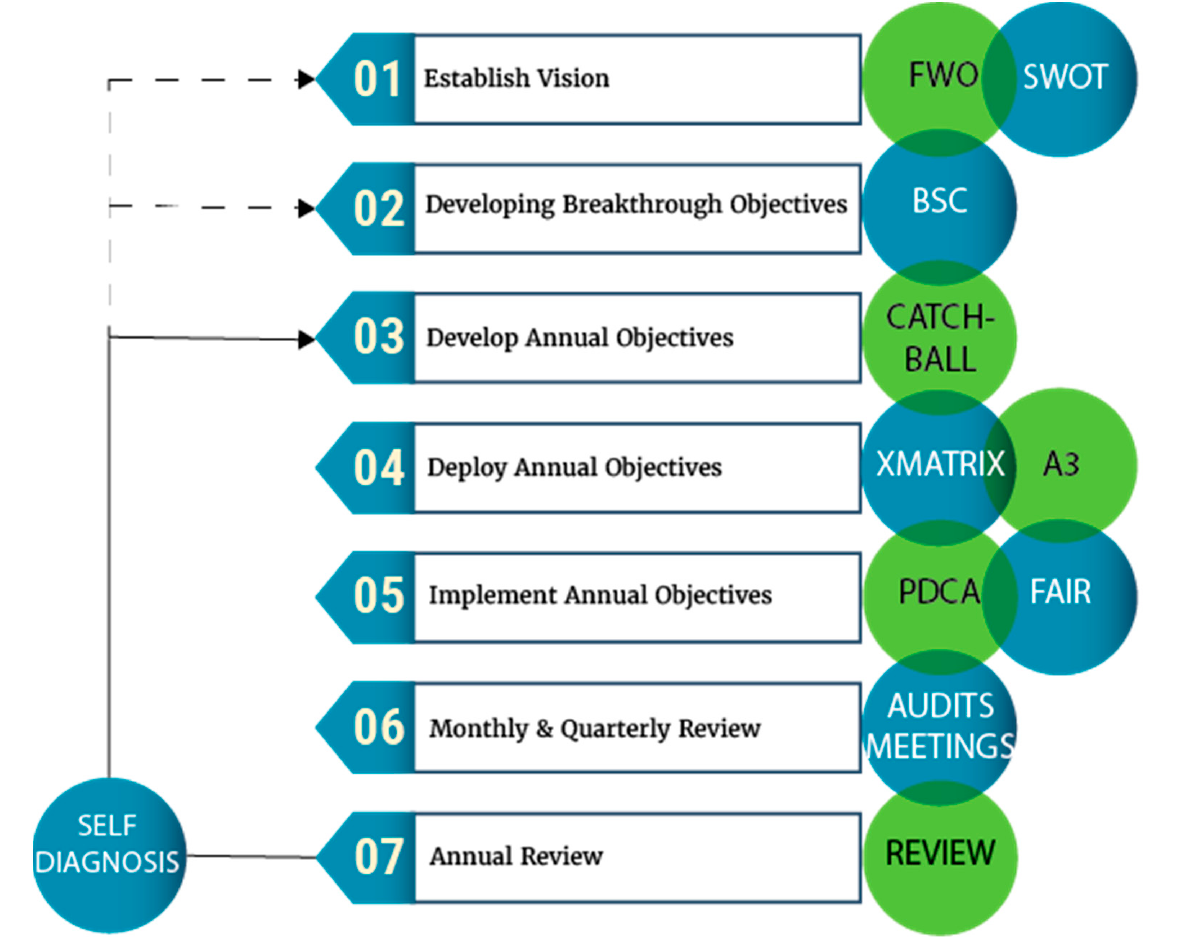
Figure 8. Hoshin Kanri process.